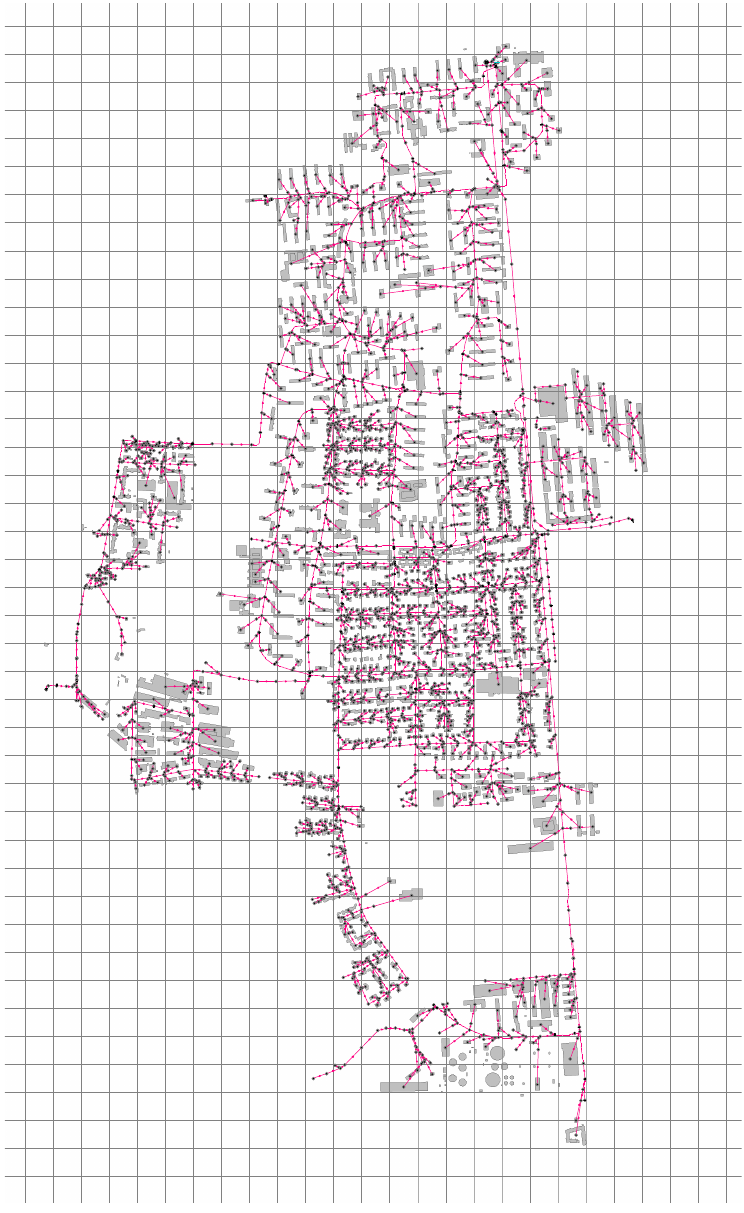
Figure 3. Sewage network used for numerical